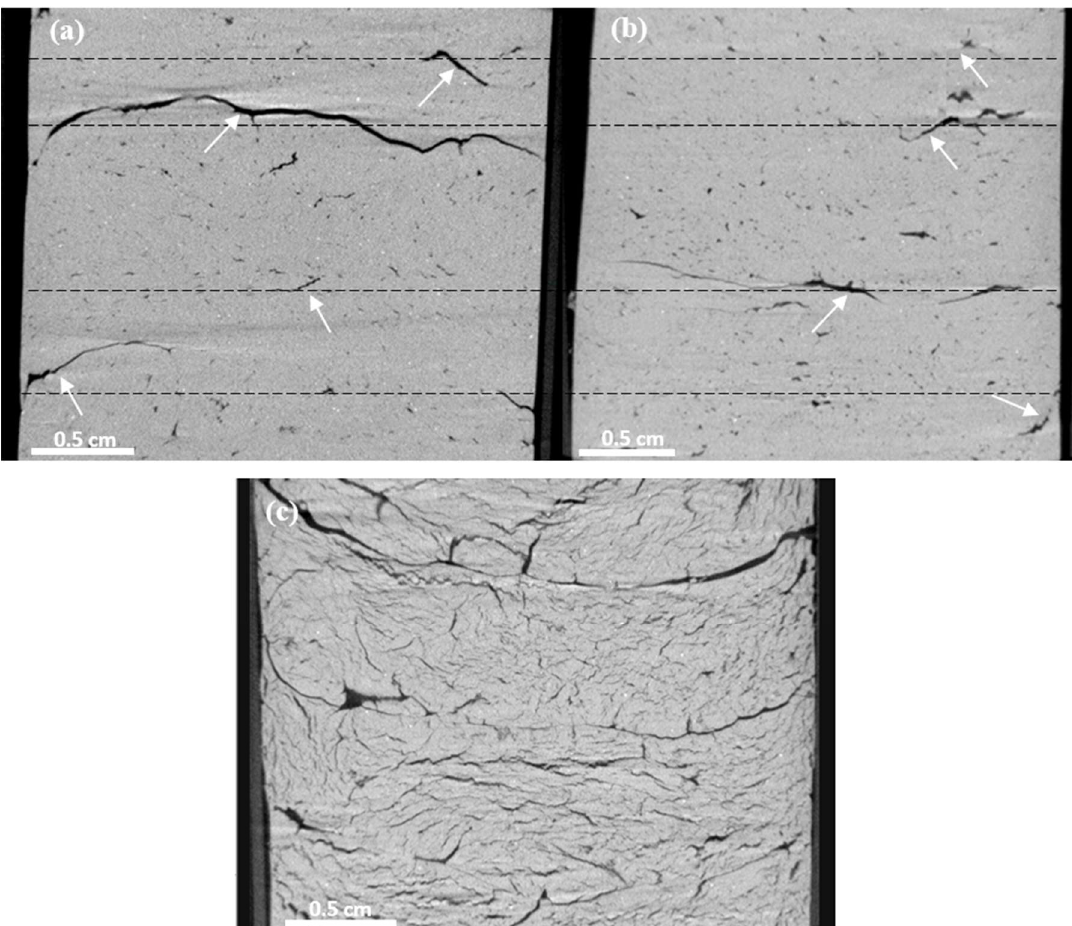
Figure 5. Perpendicular microtomographic sections through silty clay samples after drying by various methods (arrows indicate the similar exemplary fracture locations): air drying ( a ); conventional oven ( b ); microwave ( c ).